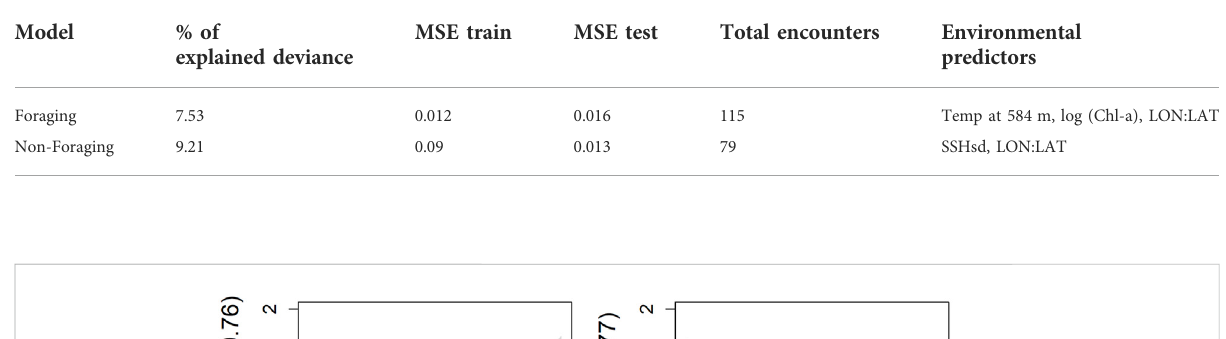
TABLE 4 Percentage of explained deviance, mean squared errors, total encounters, and selected environmental predictors for all models.